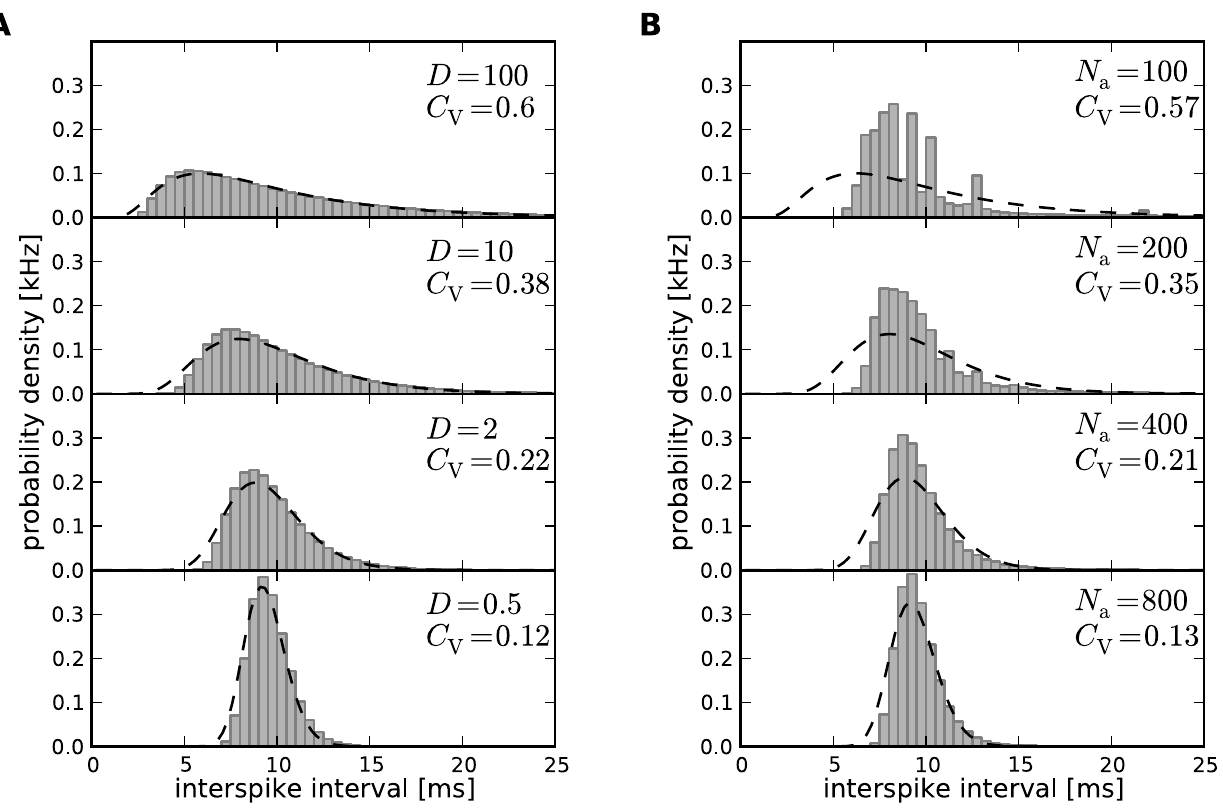
Figure 11. ISI histograms of the Traub-Miles model – deterministic vs. stochastic adaptation. A The ISI densities of the Traub-Miles neuron model with a deterministic M-type adaptation current ( N a ~ ? ) and white noise driving (Eq. (115) – gray bars) is shown along with an inverse Gaussian (Eq. (64)) with the same mean and CV (dashed lines). To keep the firing rate at about r ~ 100Hz the external driving current was adjusted from top to bottom according to I ~ 9 , 16 : 5 , 17 : 7 , 17 : 9 (in m A (cid:3) cm 2 ). Noise intensity D in units of ( m A (cid:3) cm 2 ) 2 (cid:3) ms . B The ISI densities of the Traub- Miles model in the presence of a stochastic M-type adaptation current (Eq. (116) – gray bars) is shown along with an inverse Gaussian (Eq. (64)) with the same mean and CV (dashed line). Here, the external driving current was in all cases I ~ 18 m A (cid:3) cm 2 .